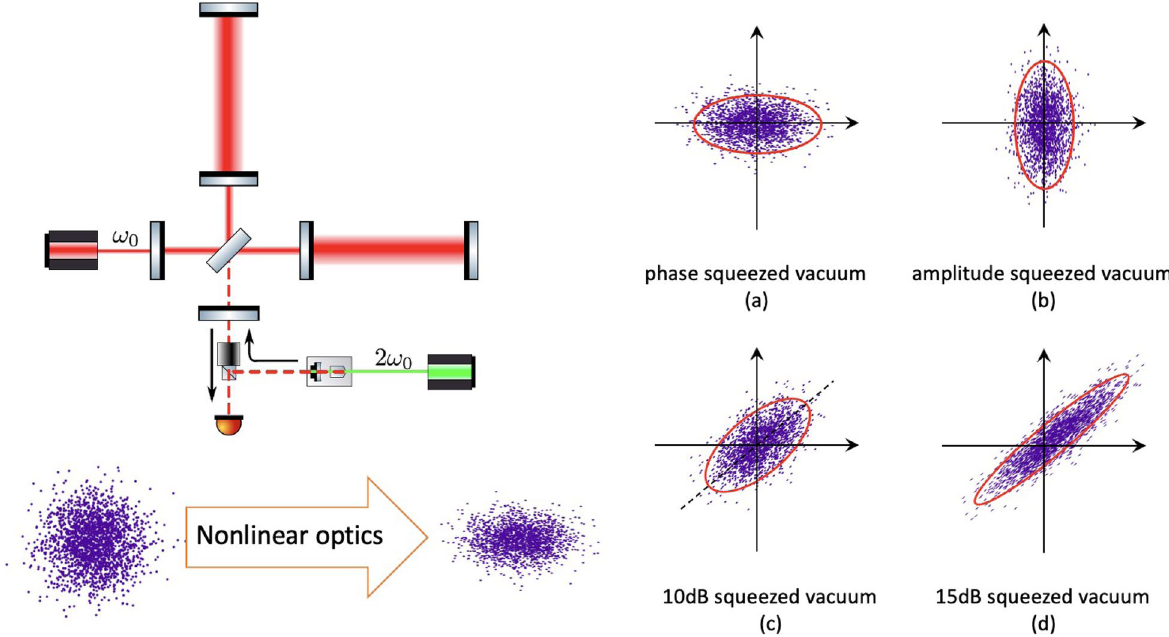
Fig. 4 Squeezing application in gravitational wave detectors. External nonlinear optics create correlation between the phase and amplitude quadrature which turns the vacuum fluctuation into a squeezed state. Squeezing in a desired angle then enters into the main interferometer which could potentially reduce the the quantum noise. (a–c) Squeezing with different squeezing angles and the elliptical squashed level illustrated in (c) and (d) visualizes the squeezing degree, here with 10 dB and 15 dB